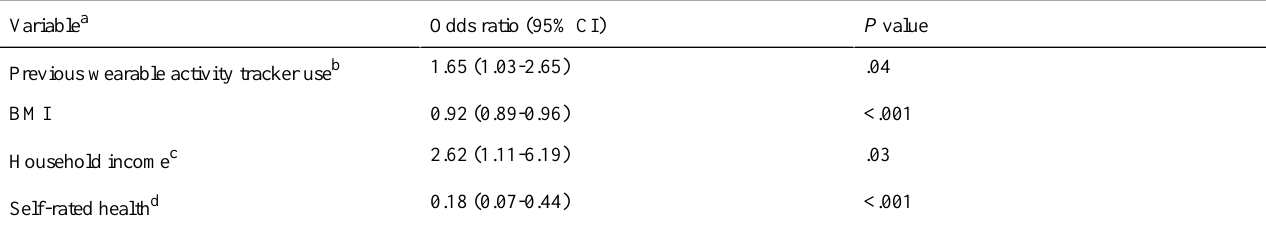
Table 3. Association between wearable activity tracker use and meeting the recommended amount of physical activity